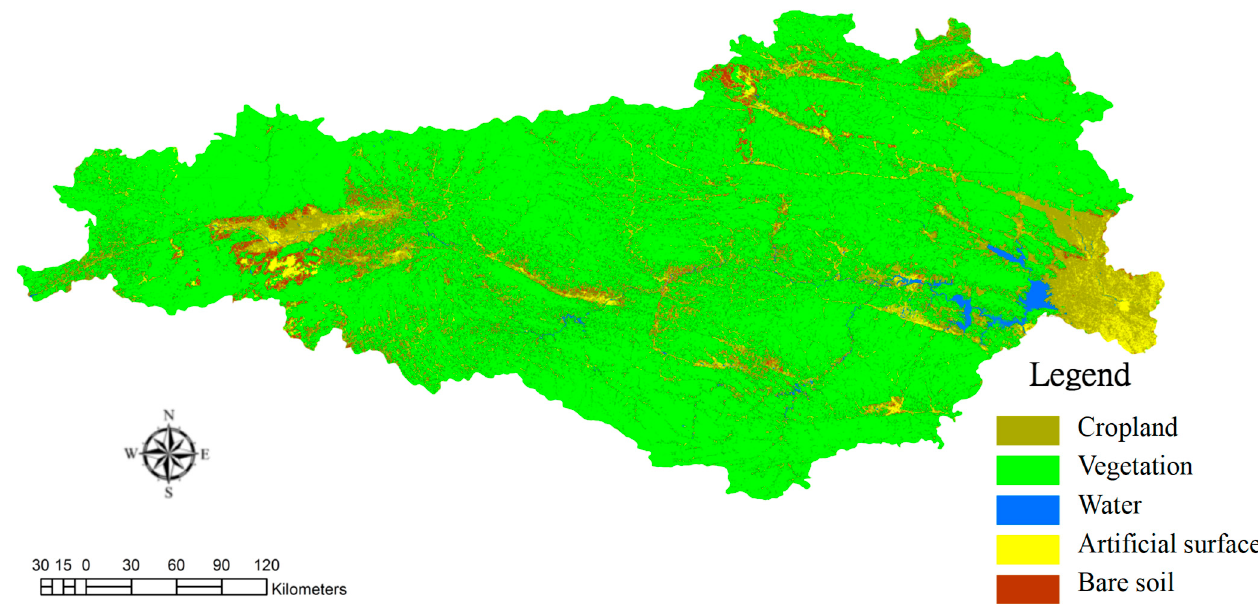
Figure 5. Land use of Danjiangkou water source in 2019.